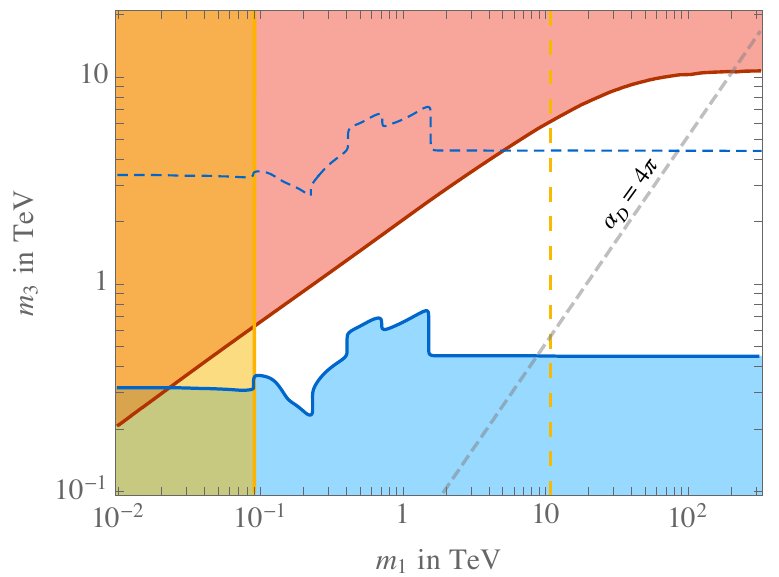
Figure 9 . Isocurve of thermal relic density corresponding to the observed DM abundance (red curve), in the theory with EW doublets with a = 1 / 2 and N DC = 4 . Colored regions are excluded by current data from LHC searches (blue area), observations of gamma rays from dwarf spheroidal galaxies (yellow area) and by requiring that dark particles do not overclose the Universe (red area). The dashed blue curve shows the expected exclusion reach of a 100 TeV FCC with 20 ab − 1 , while the dashed yellow curve shows the sensitivity of the CTA observatory from observations of the Galactic Center, assuming an Einasto DM profile. Our assumption of a weakly-coupled U(1) D gauge factor breaks down naively for points on the right of the dashed gray line. The plot assumes ε = 10 − 6 , which corresponds to prompt dark photon decays at high-energy